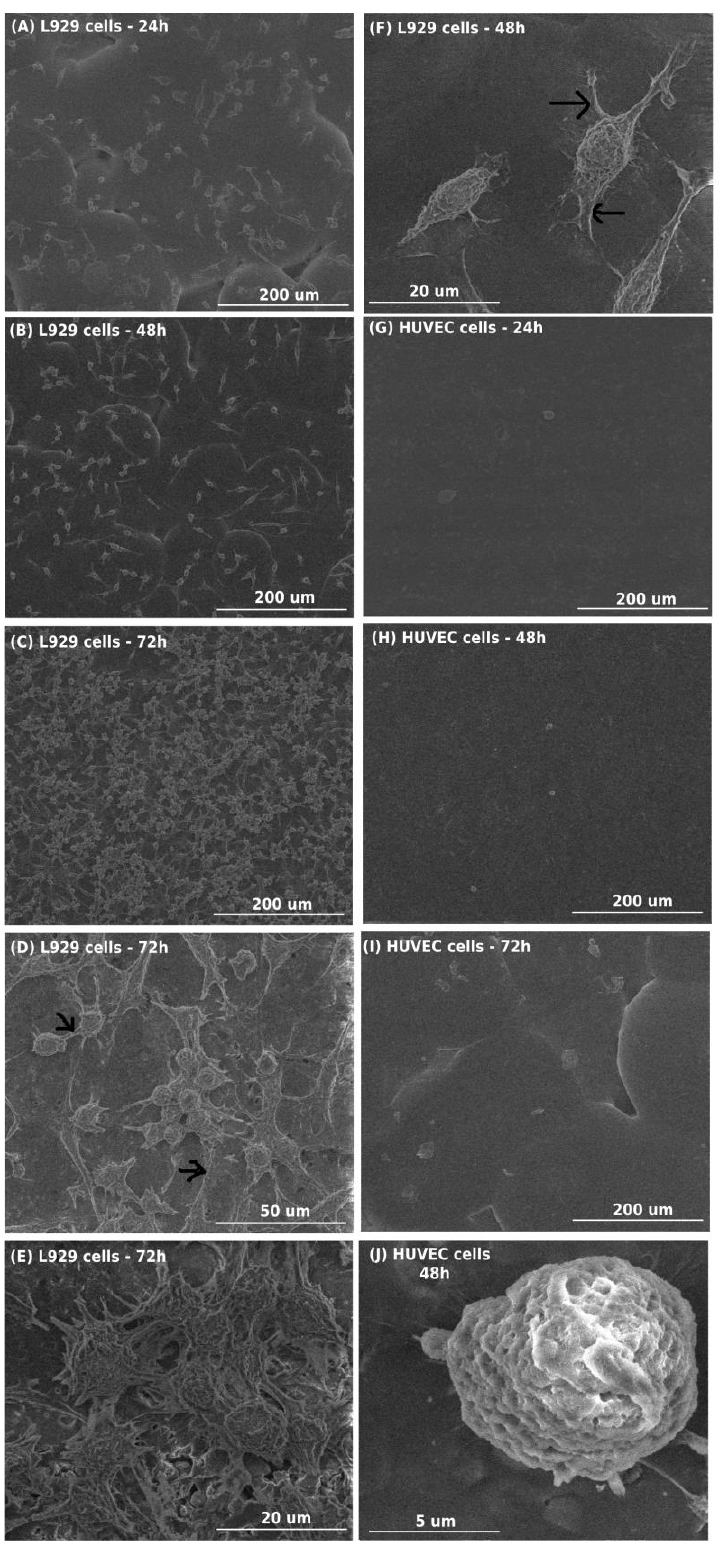
Figure 4. Scanning electron microscopy micrographs showing L929 fibroblasts ( A – C ) and HUVEC cells ( G – I ) cultured on the surfaces of the PCL + ( 1 ) 10 wt.% for 24, 48 and 72 h. Cell line names, time of incubation and image scales are presented in the figures. Arrows indicate filopodia spread between the cells ( D ) or filopodia attaching cells to the foil’s surface ( F ). Figure ( E ) presents L929 cells producing the extracellular matrix and growing on top of each other. Figure ( J ) shows rounded shape of HUVEC